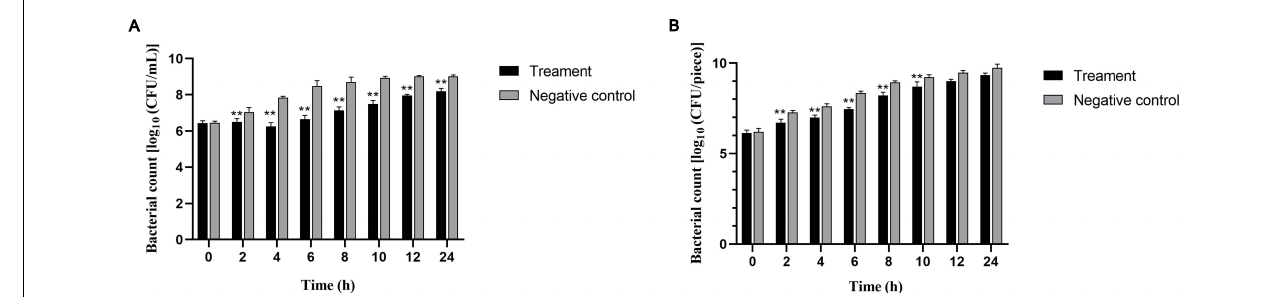
FIGURE 5 | Effectiveness of Salmonella phage vB_SalP_TR2 in reducing S. Albany in milk (A) and chicken meat (B) . The phage vB_SalP_TR2 and S. Albany were mixed at an MOI of 0.01 in milk and chicken meat. The number of S. Albany was determined at 2, 4, 6, 8, 10, 12, and 24 h. All data are shown as the mean ± SD. **Significant at p <